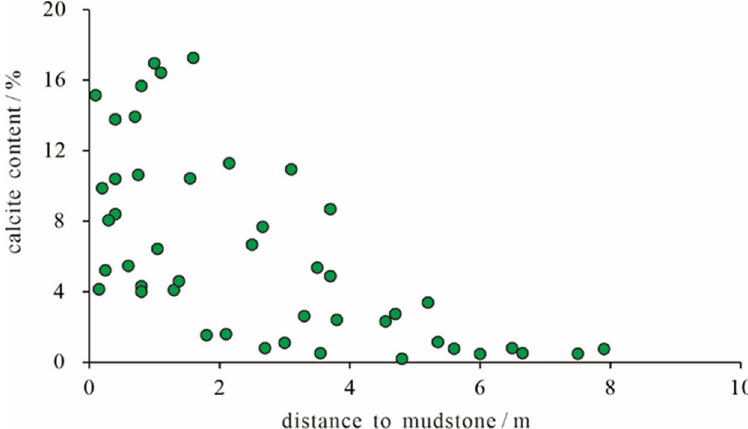
Figure 7. Correlation between calcite cement content and the distance to